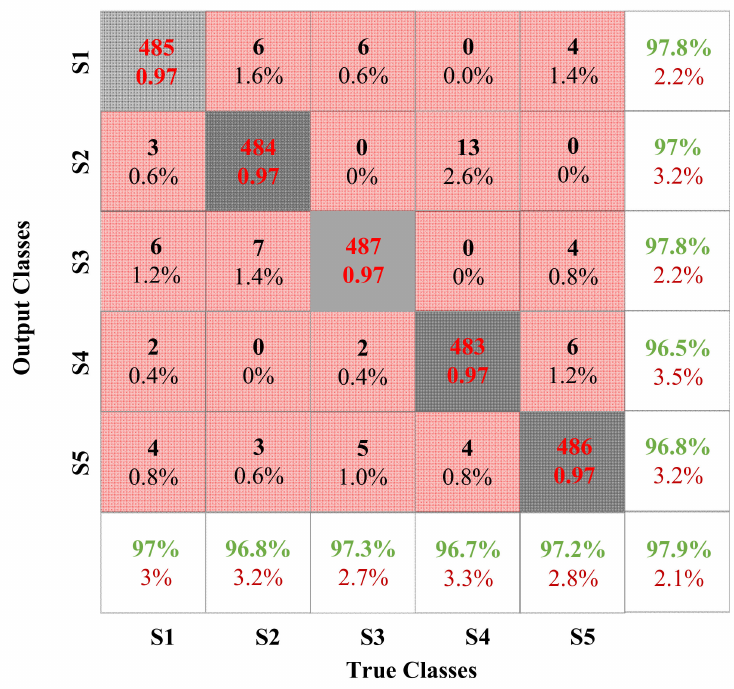
Figure 10. Confusion matrix of the proposed